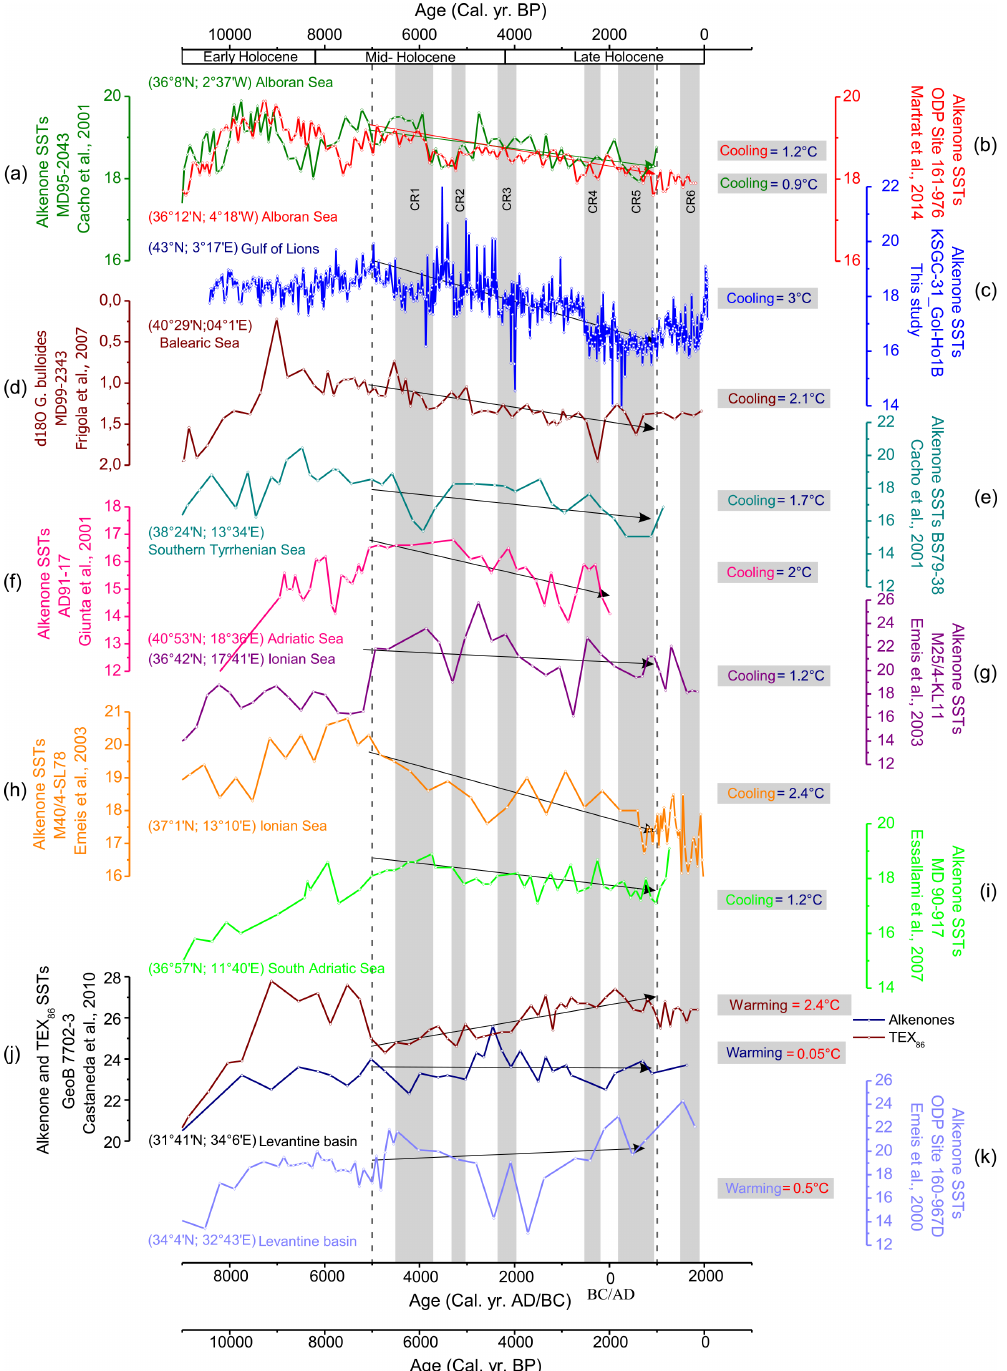
Figure 3. SST records in the Mediterranean Sea over the Holocene. (a) Core MD95-2043 from the Alboran Sea (Cacho et al., 2001). (b) ODP Site 161-976 from the Alboran Sea (Martrat et al., 2014). (c) Core KSGC-31_GolHo-1B from the Gulf of Lions (this study). (d) G. bulloides oxygen isotopic record for core MD99-2343 from the Balearic Sea (Frigola et al., 2007). (e) Core BS79-38 from the Southern Tyrrhenian Sea (Cacho et al., 2001). (f) Core AD91-17 from the Adriatic Sea (Giunta et al., 2001). (g) Core M25/4-KL11 from the Ionian Sea (Emeis et al., 2003). (h) Core M40/4-SL78 from the Ionian Sea (Emeis et al., 2003). (i) Core MD90-917 from the Southern Adriatic Sea (Essallami et al., 2007). (j) Core GeoB 7702-3 from the Levantine basin (Castañeda et al., 2010). (k) ODP Site 160-967D from the Levantine basin (Emeis et al., 2000). Vertical grey bars represent the time interval of the CRs, no. 1–6. The grey vertical dashed lines indicate the time interval used to calculate SST trends (7000 to 1000yrsBP). SST trends between 7000 and 1000 years are marked by arrows and the amplitudes ( ◦ C/6kyr) are indicated in the right of each